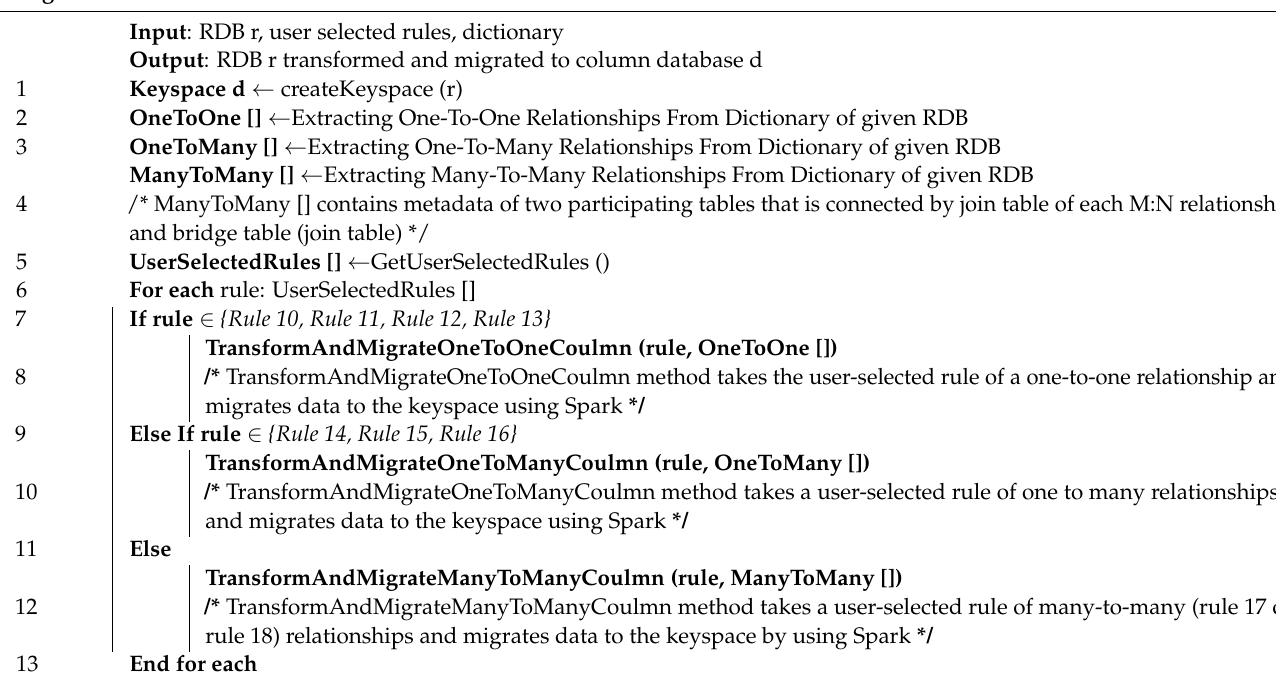
Algorithm 2 : TRANSFORMATION AND MIGRATION FROM AN RDB TO A COLUMN